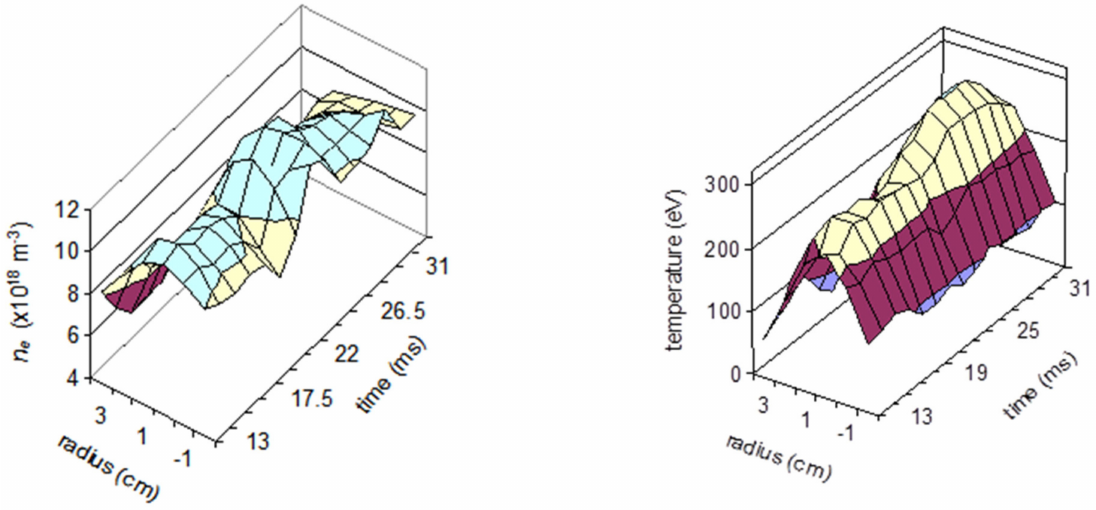
Figure 15. Density ( left ) and temperature ( right ) profiles obtained in ISTTOK with the HIBD using two species